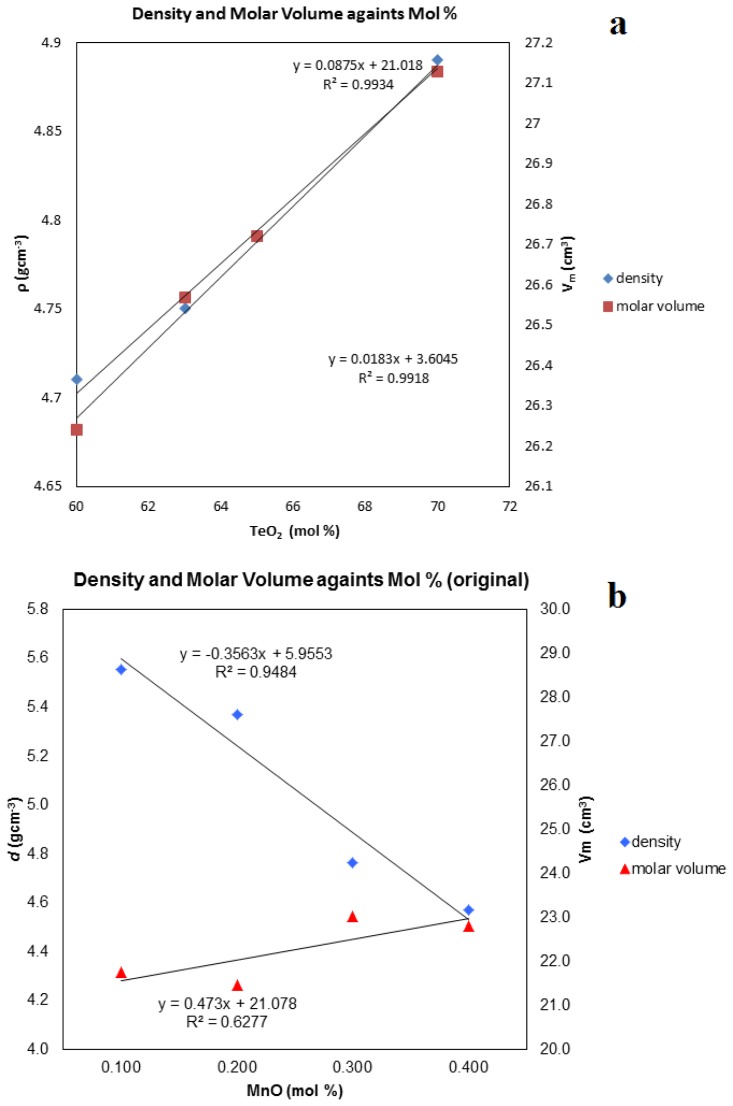
The density and molar volume of (a) borotellurite glasses; (b) the original (100–x) [(B2O3)30(TeO2)70]-xMnO glass samples and (c) the remelted samples.